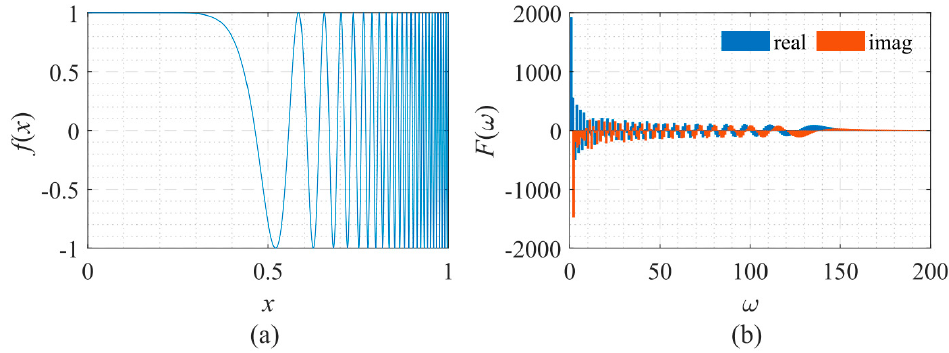
Figure 14. Signal described by Equation (12) with its frequency spectrum. ( a ) The function to be fitted. ( b ) The spectrum of the function.